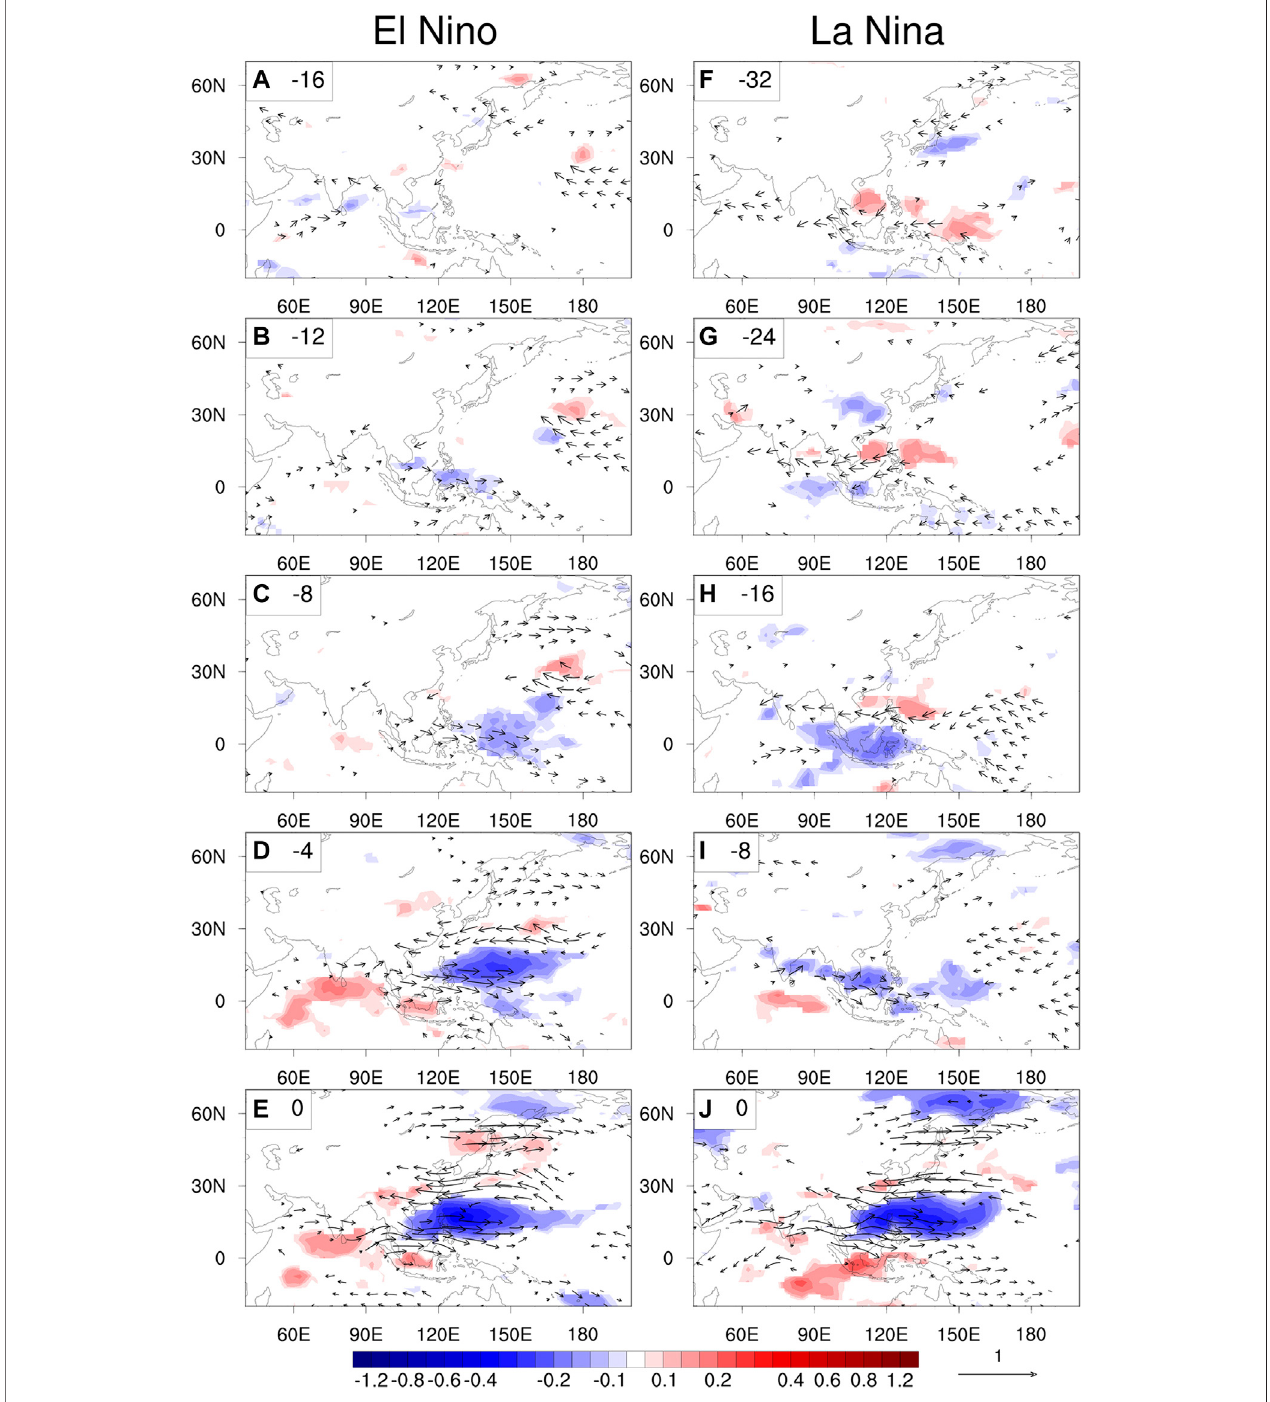
FIGURE5| Theregressioncoef fi cientpatternsoftheOLR(shaded,passingthe95%con fi dencelevel)andwind(vectorwiththezonalcomponentpassingthe95% con fi dence level) anomalies from Day -16 or Day -32 to Day 0 regressed onto the EAP index in El Niño years (A – E) and La Niña years (F – J) .